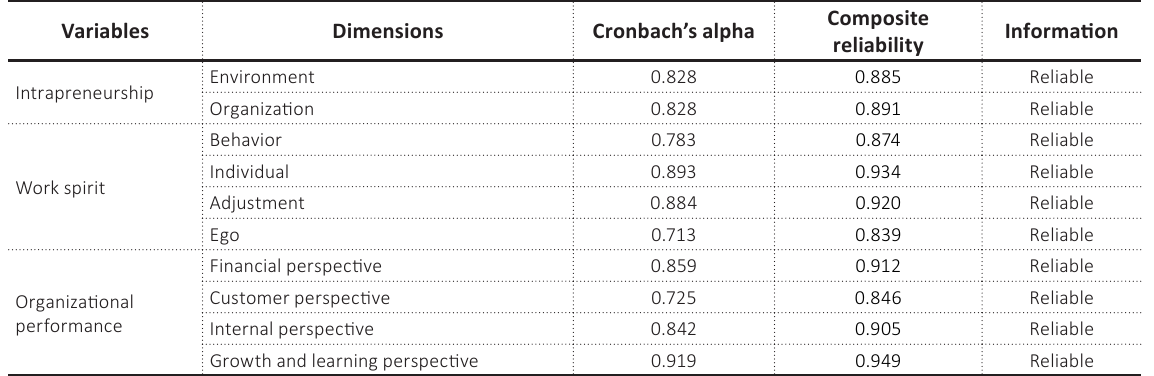
Table 3. Cronbach’s alpha and composite